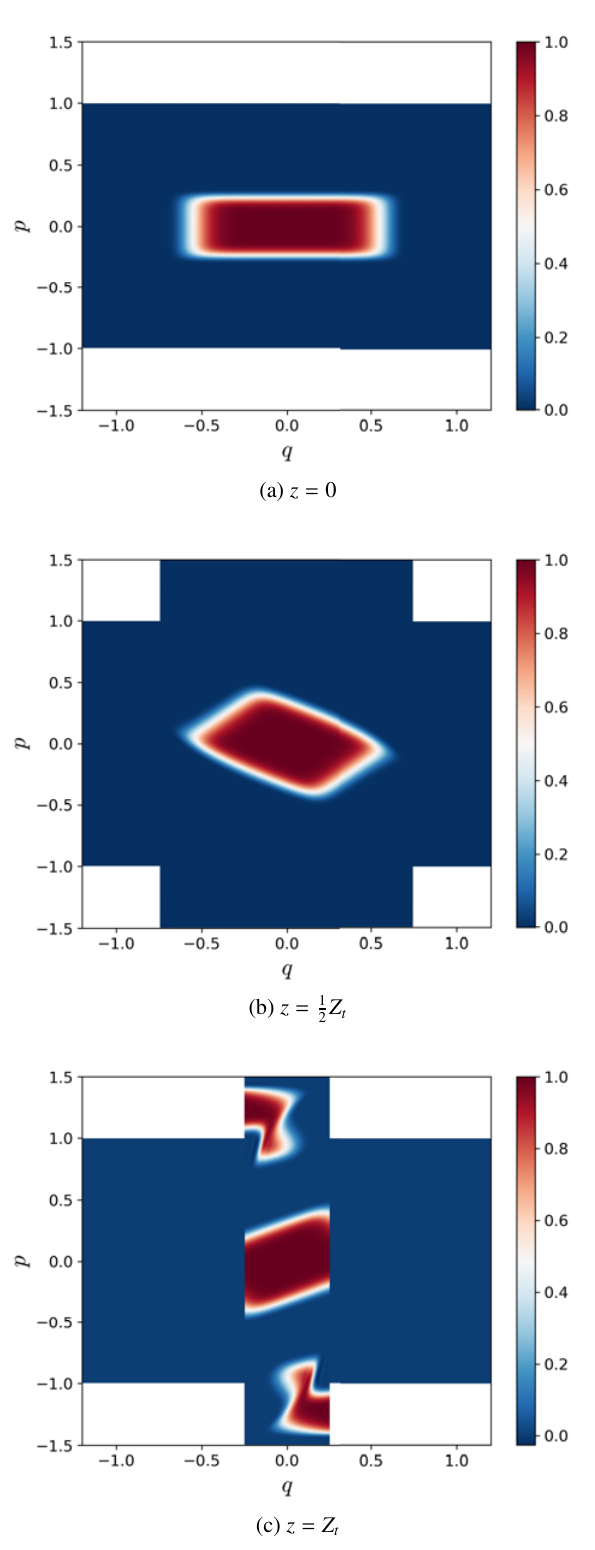
Figure 1: Distributions of ρ for the DTIRC